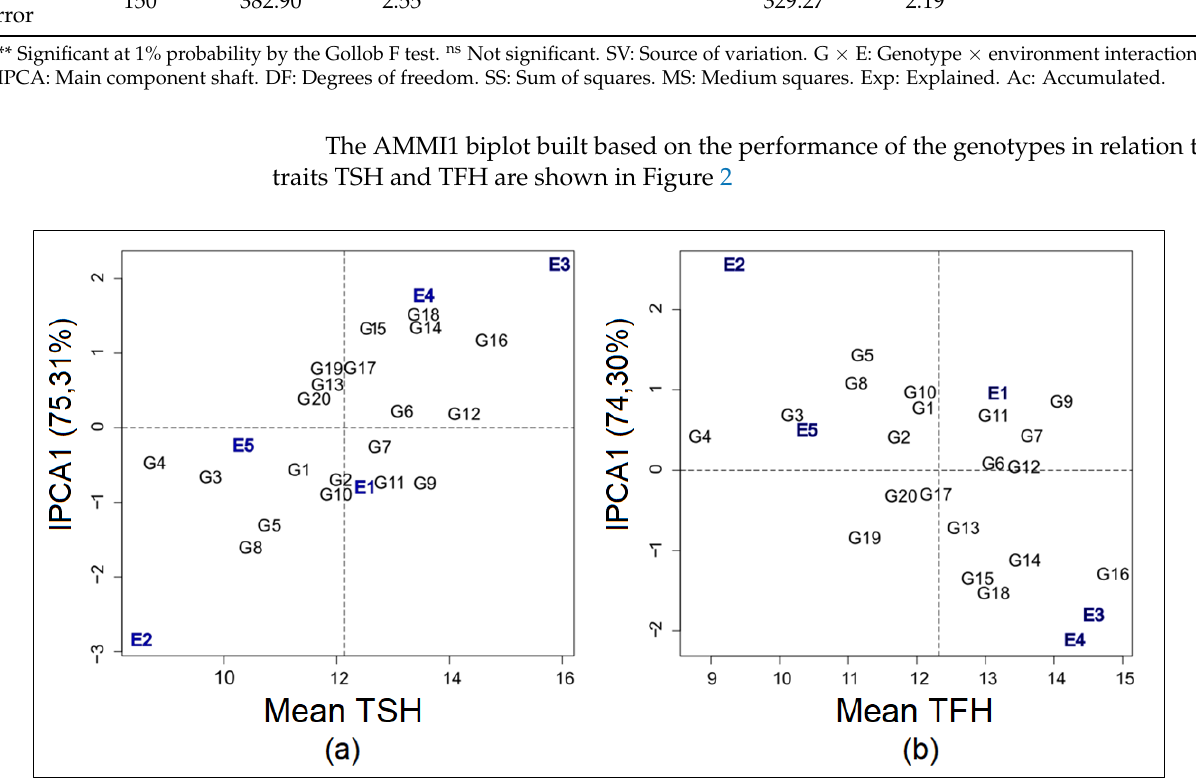
Figure 2. Biplot AMMI1 to TSH ( a ) e TFH ( b ) in 20 sugarcane genotypes evaluated in 5 sugarcane microregions in the State of Pernambuco. G: Genotype and E: Environment.